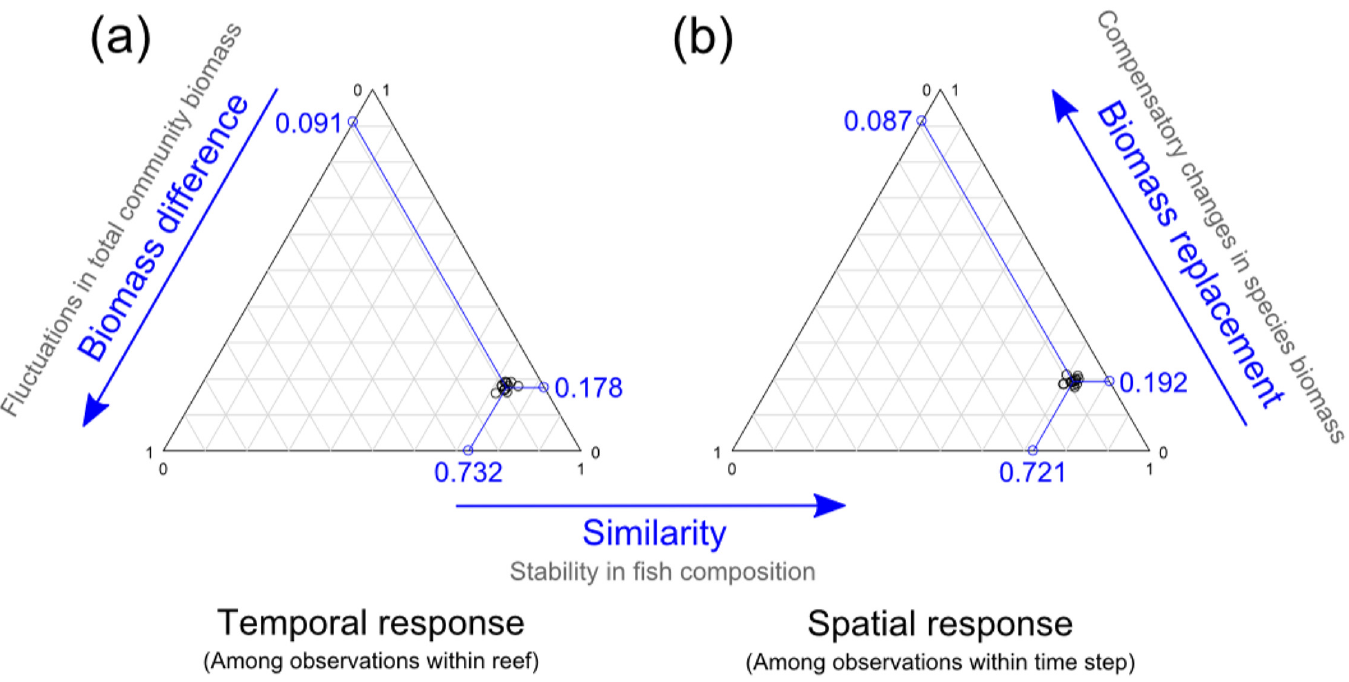
Fig 4. Triangle plots illustrating the contributions of three mechanisms: stability in species composition, compensatory changes in biomass among species and fluctuations in total community biomass to the temporal and spatial responses of fish communities. (a) Temporal response measure as beta diversity for the 13 spatial groups (13 reefs with 14 time steps for each reef). (b) Spatial response measure as beta diversity for the 14 temporal groups (14 time steps with 13 reefs for each time steps). Blue points represent the means over the different time step pairs (or reef